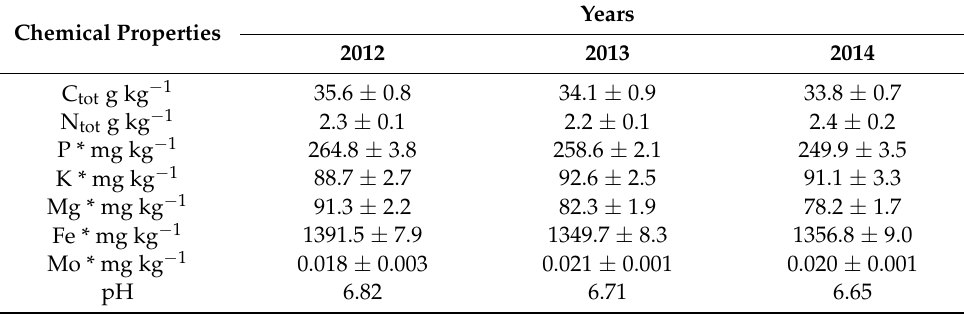
Table 1. Basic soil